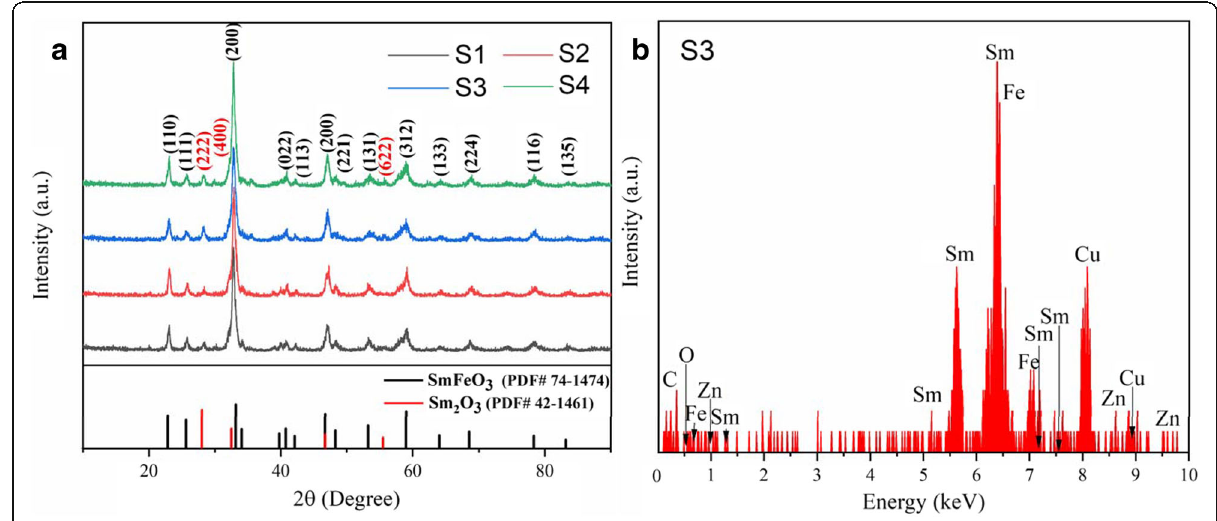
Fig. 2 a XRD pattern of S1, S2, S3, and S4. b EDS spectrum of